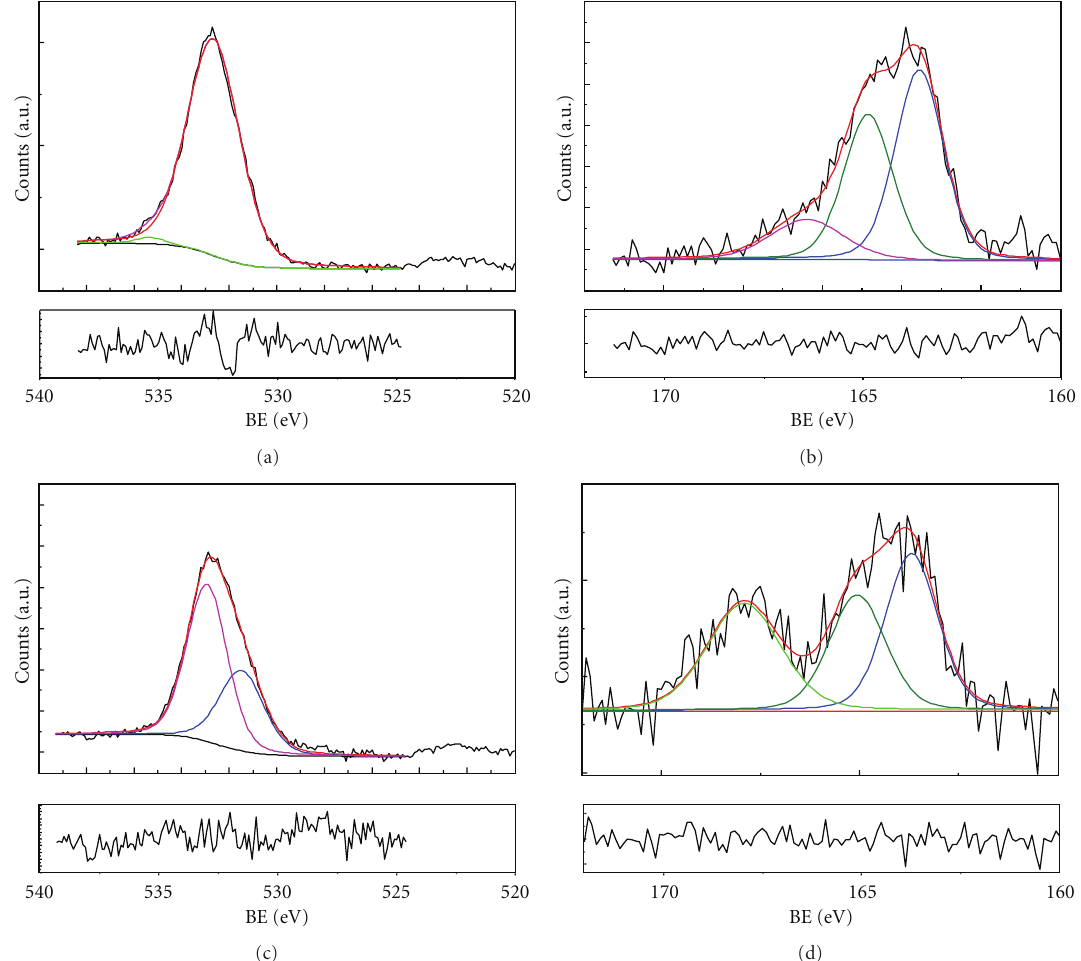
Figure 5: XPS core-level spectra of O(1s) (a, c) and S(2p) bands (c, d) for PEDOT/ClO 4 (a, b) and PEDOT/LS (c, d)